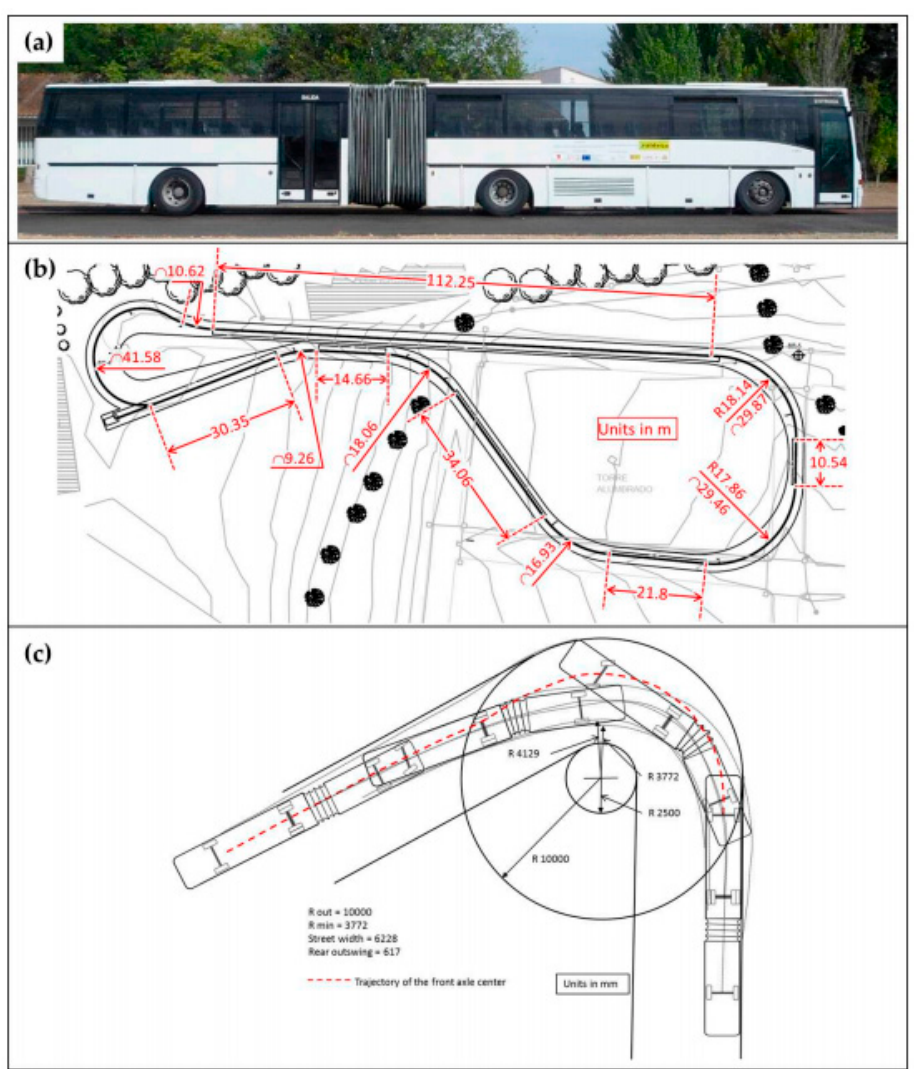
Figure 5. ( a ) Tested articulated bus, ( b ) inner road dimensions, ( c ) bus trajectory analysis.